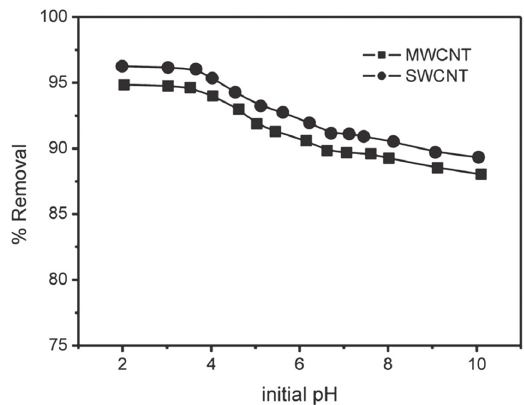
Figure 4. Effect of pH on the adsorption of RB-4 dye on MWCNT and SWCNT. Conditions: C 1000.0 mg L –1 of dye solution; mass o of adsorbent of 30.0 mg; the temperature was fixed at 298 K. Time of contact between the dye and adsorbate was fixed in 4.0